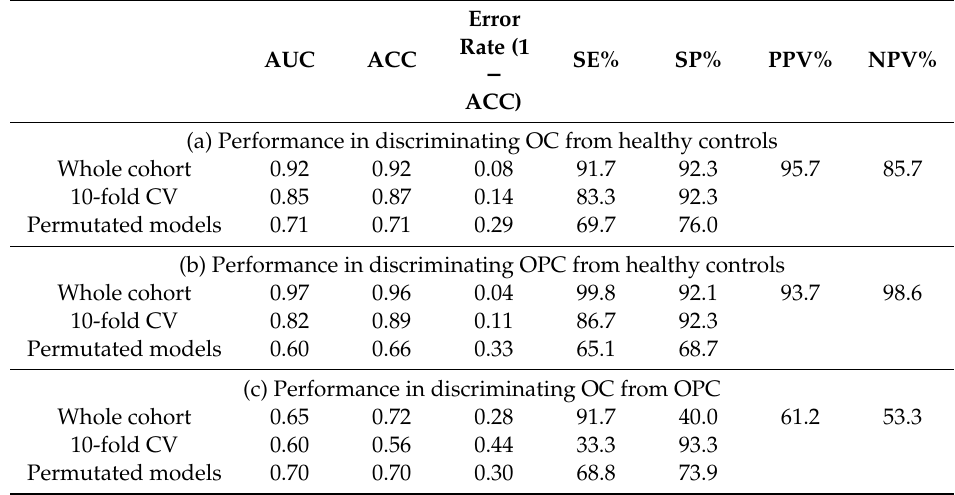
Table 5. CombiROC curve analyses and validation tests of the quadruple-methylation marker